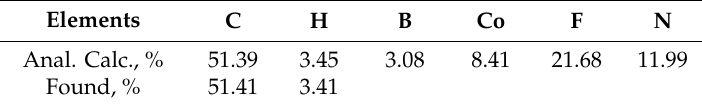
Table 1. The elemental analysis data for C 30 H 24 B 2 CoF 8 N 6